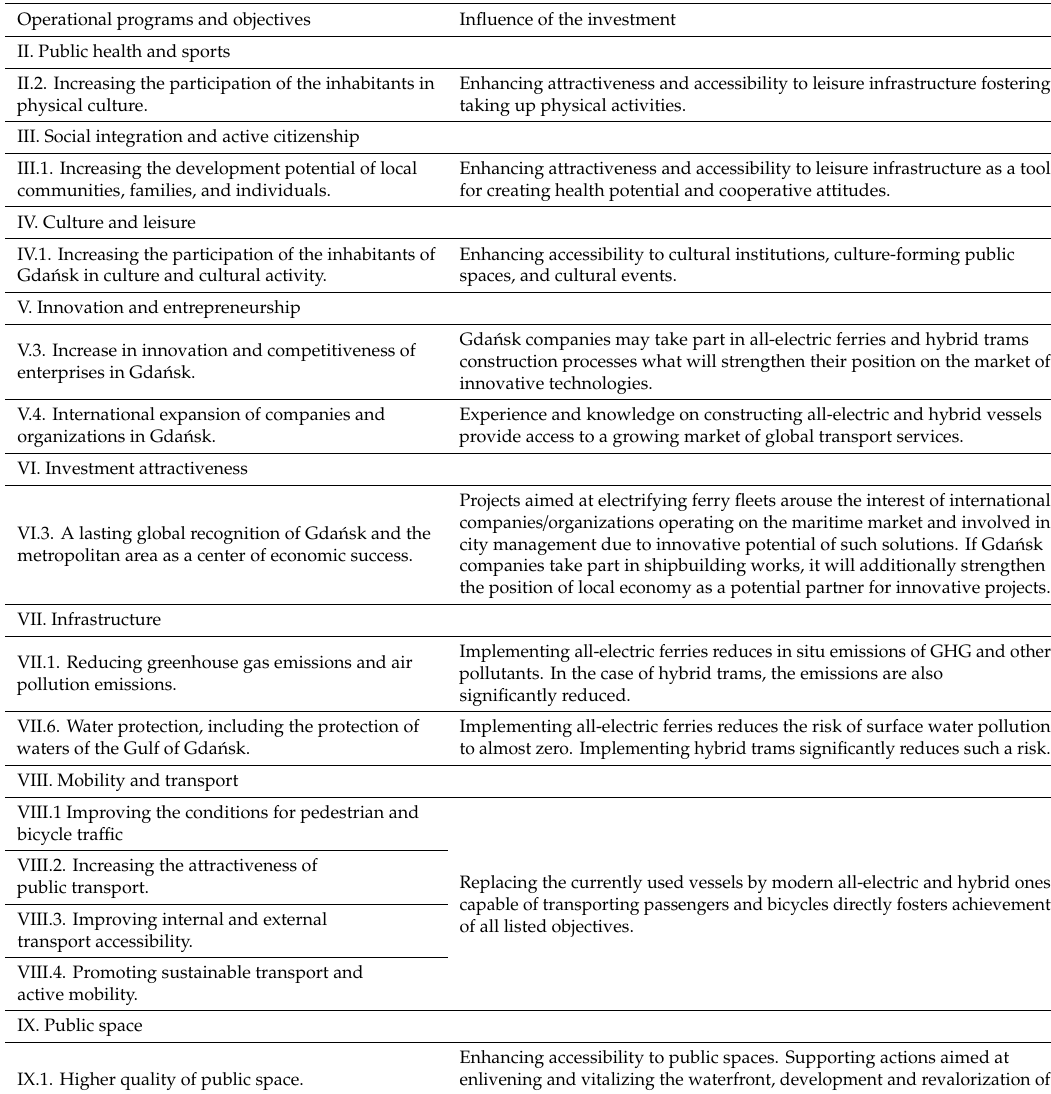
Table 7. Implementation of all-electric and hybrid ferries in the transport system of Gda´nsk in the context of achievement of the 2023 operational program’s